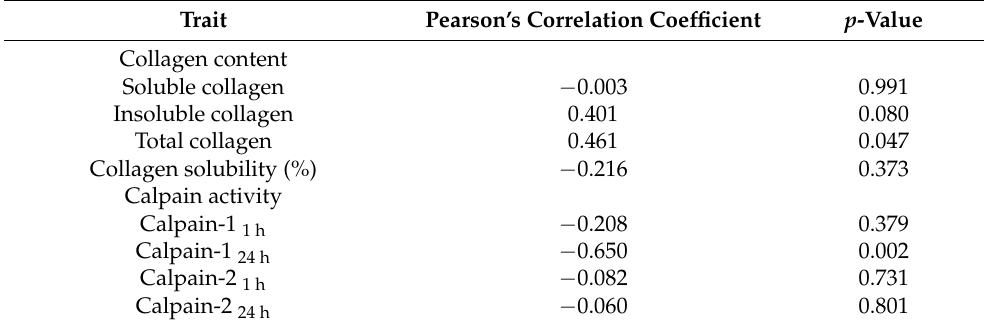
Table 4. Pearson’s correlation coefficients between collagen content, calpain activity, and shear force value of Longissimus thoracis m. of Southern Thai native goats and Three-way crossbred goats. Trait Pearson’s Correlation Coefficient p